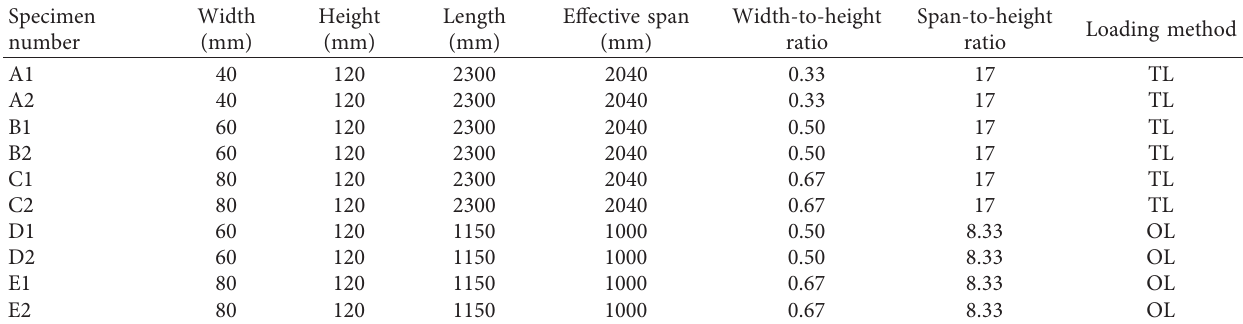
Table 1: Size table of